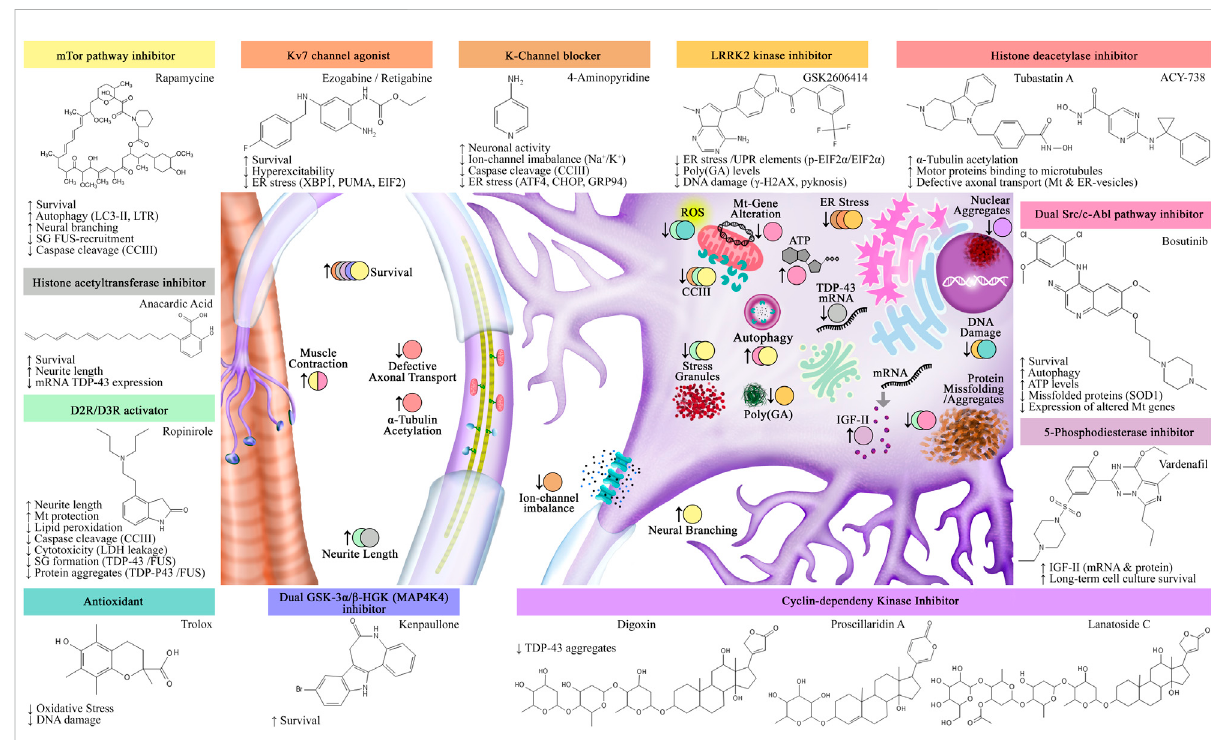
FIGURE 4 Assessed drugs using iPSC-ALS modeling. Identi fi ed drugs and their effects in both iPSCs-MNs and muscle fi bers. Abbreviations: SG: stress granules; Mt: mitochondria; ER: endoplasmic reticulum; UPR: unfolded protein